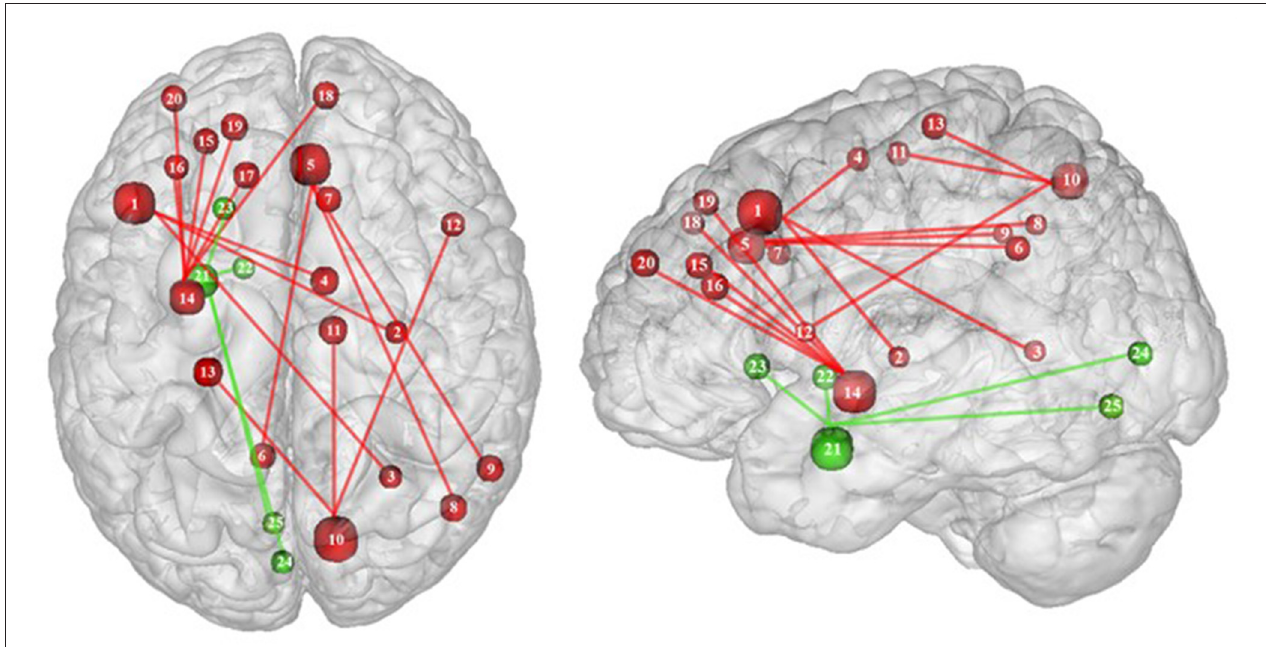
FIGURE 6 | Functional connectivity during inhibition. Red and green connections indicate hyperconnectivity and U-shaped connectivity, respectively, in obese in comparison with lean participants during inhibition (see Table 7 for precise coordinates). Regions n ◦ 1, 5, 10, 14, and 21 are seed regions. 1 = dorsolateral prefrontal cortex, 2 = putamen, 3 = cingulate cortex, 4 = supplementary motor area, 5 = pre-supplementary motor area, 6 = precuneus, 7 = cingulate cortex, 8–9 = parietal cortex, 10 = precuneus, 11 = supplementary motor area, 12 = ventrolateral prefrontal cortex, 13 = sensory cortex (53), 14 = putamen, 15–19 = dorsolateral prefrontal cortex, 20 = dorsomedial prefrontal cortex, 21 = amygdala, 22 = pallidum, 23 = putamen, 24–25 = visual cortex